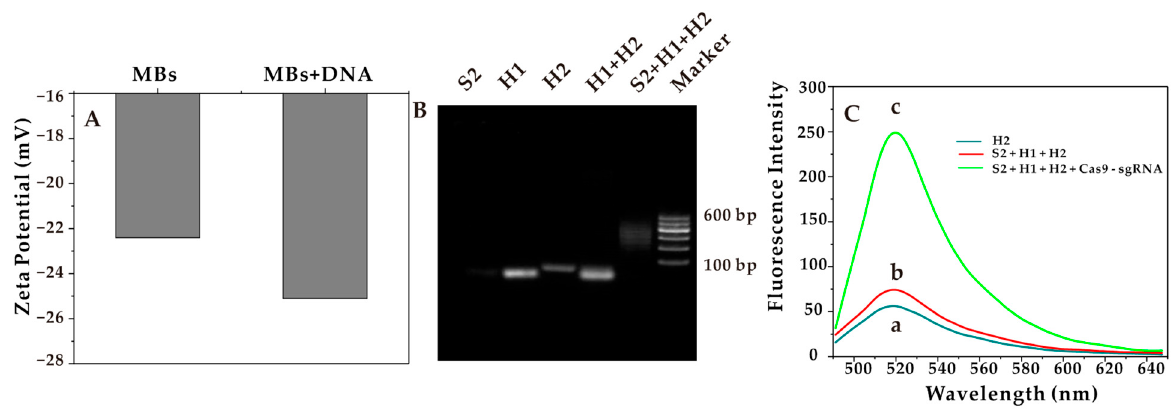
Figure 1. ( A ) Zeta potential of MBs and MBs + DNA. ( B ) Agarose gel characterization of the HCR products. ( C ) Fluorescence intensity after the introduction of CRISPR-Cas9.